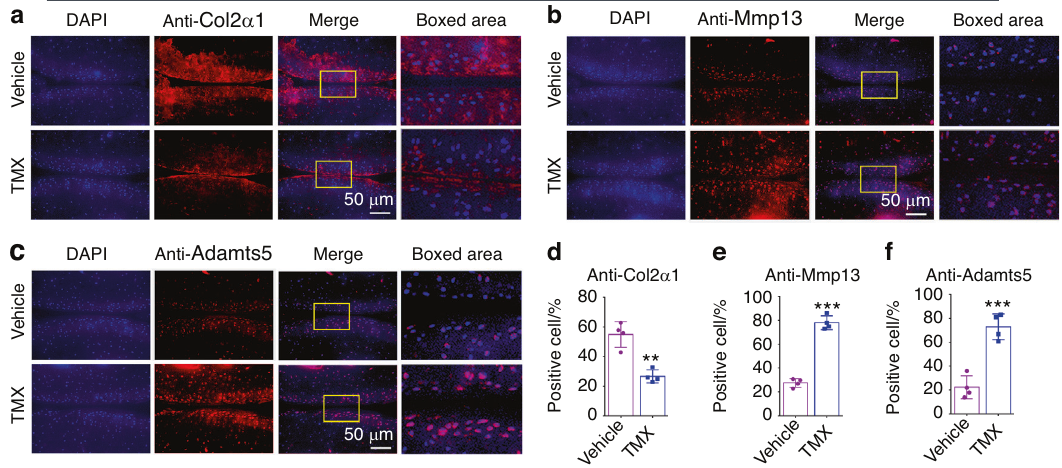
Runx1 f/f Col2 (cid:2) 1-Cre ER male mice (3-month-old) knee joint articular cartlia g e